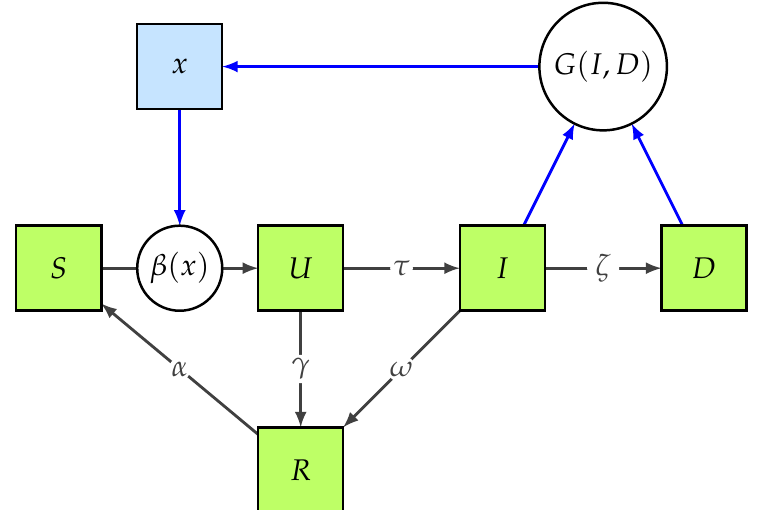
Figure 1. Schematic representation of the proposed Infection Game model. Two feedback mechanisms are at work, coupling the infection model and the RE: (1) The number of known infected people I and of deaths D influences the cooperation dynamics by changing the game through the term G ( I , D ) ; (2) the cooperation x influences the infection rate β ( x )